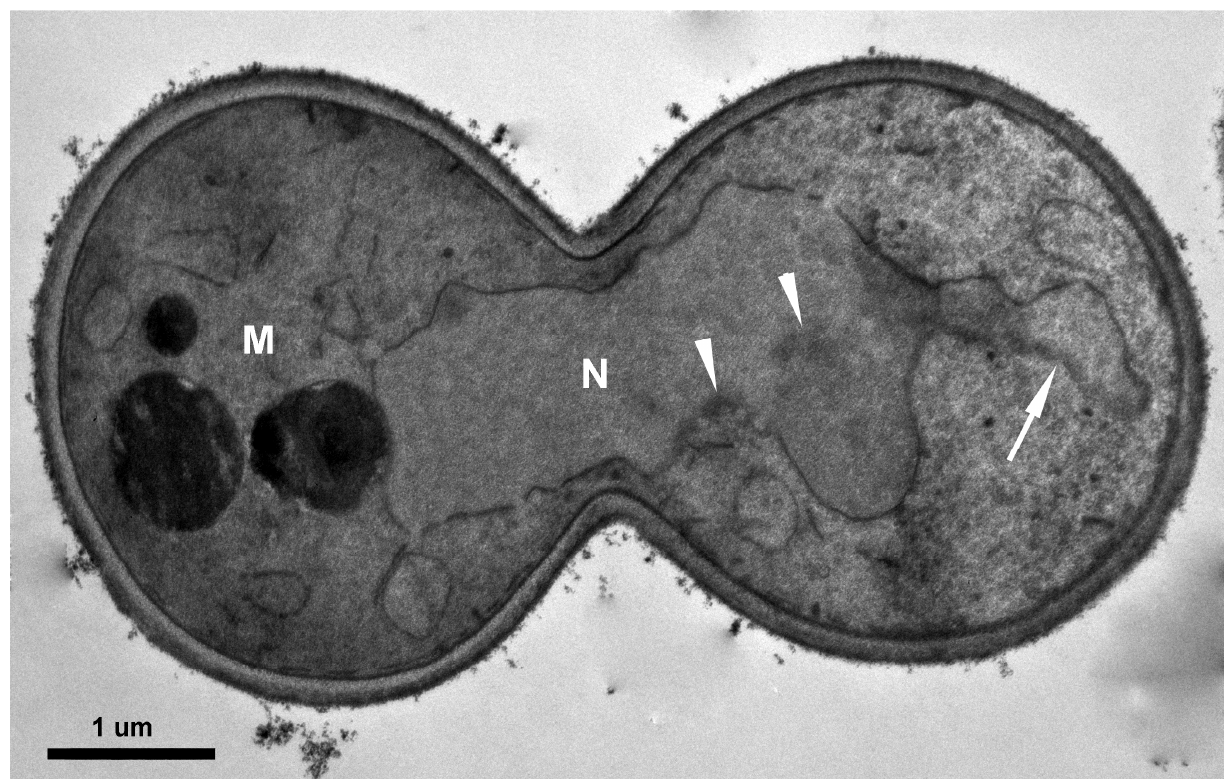
FIGURE 3: TEM image of pds5-1 mutant showing the nucleus unable to divide when switched to non-permissive temperature. It also shows chromatin condensation (arrowhead) and nucleus with protruding tube (arrow), both typical markers of apoptotic cell death. N = nucleus. M = mother cell, as suggested by the